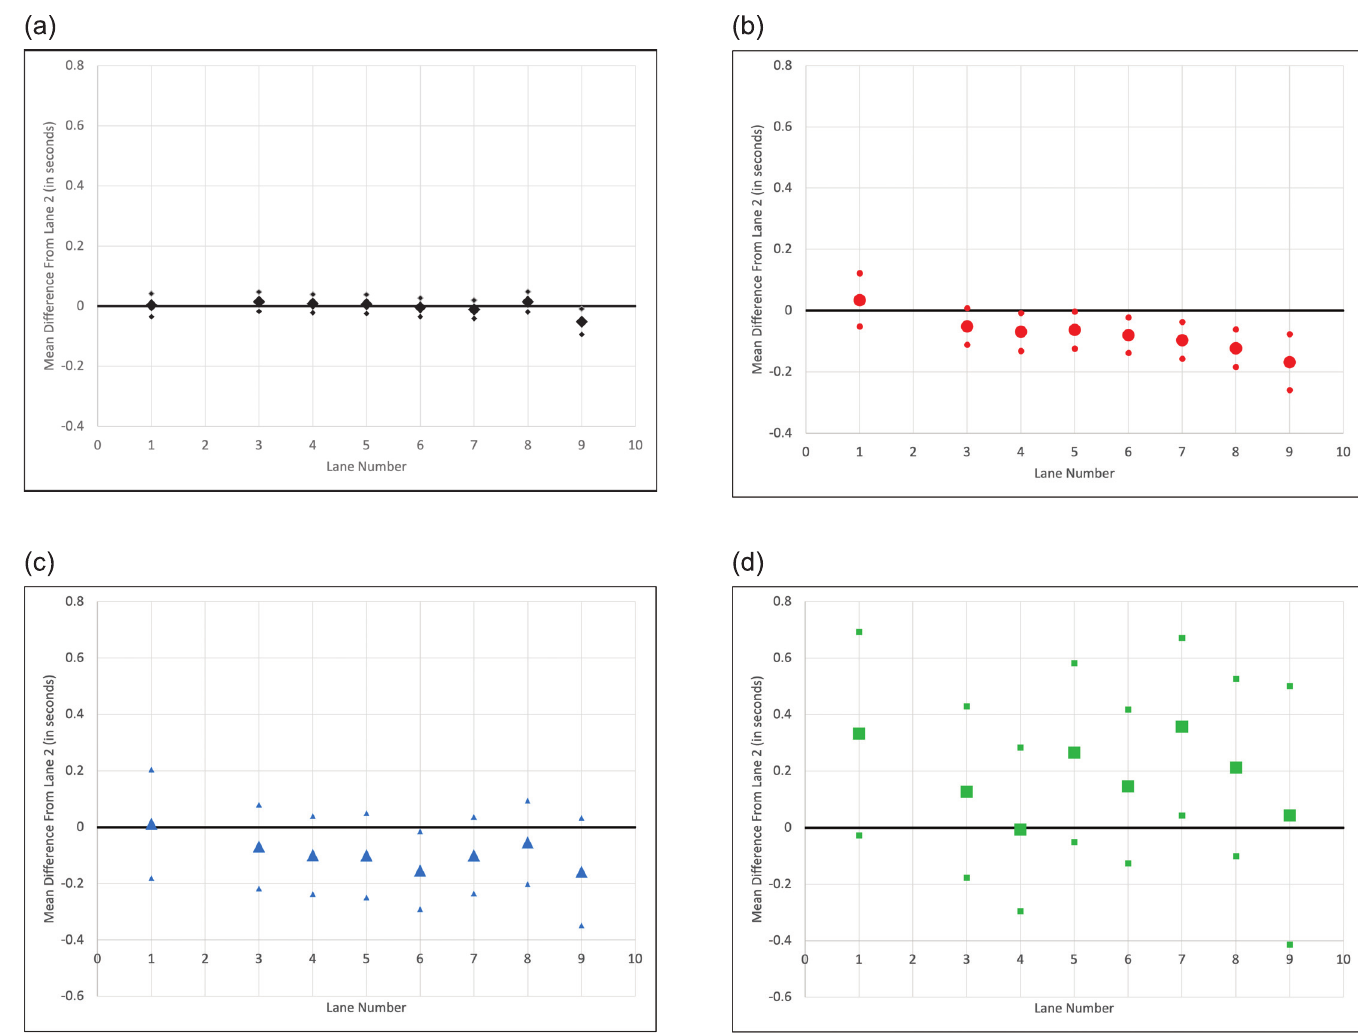
Fig 1. Graphical display of regression results. These figures plot the estimated lane effects using pooled men’s and women’s data and excluding outliers. 95% confidence intervals are denoted by the smaller